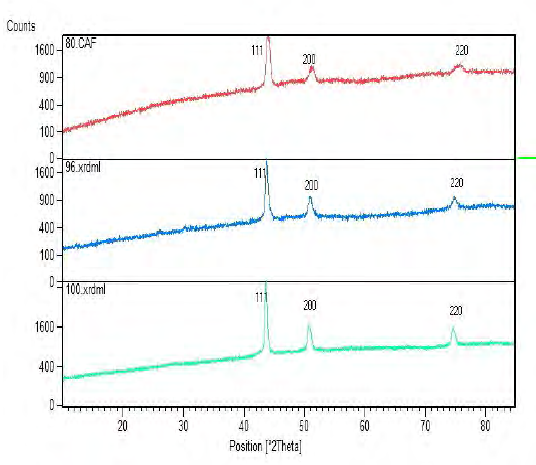
Fig. 1. XRD patterns of the Ni-Cu(3nm)/Cu(1nm), Ni- Cu(3nm)/Cu(2nm) and Ni-Cu(3nm)/Cu(3nm) multilayers